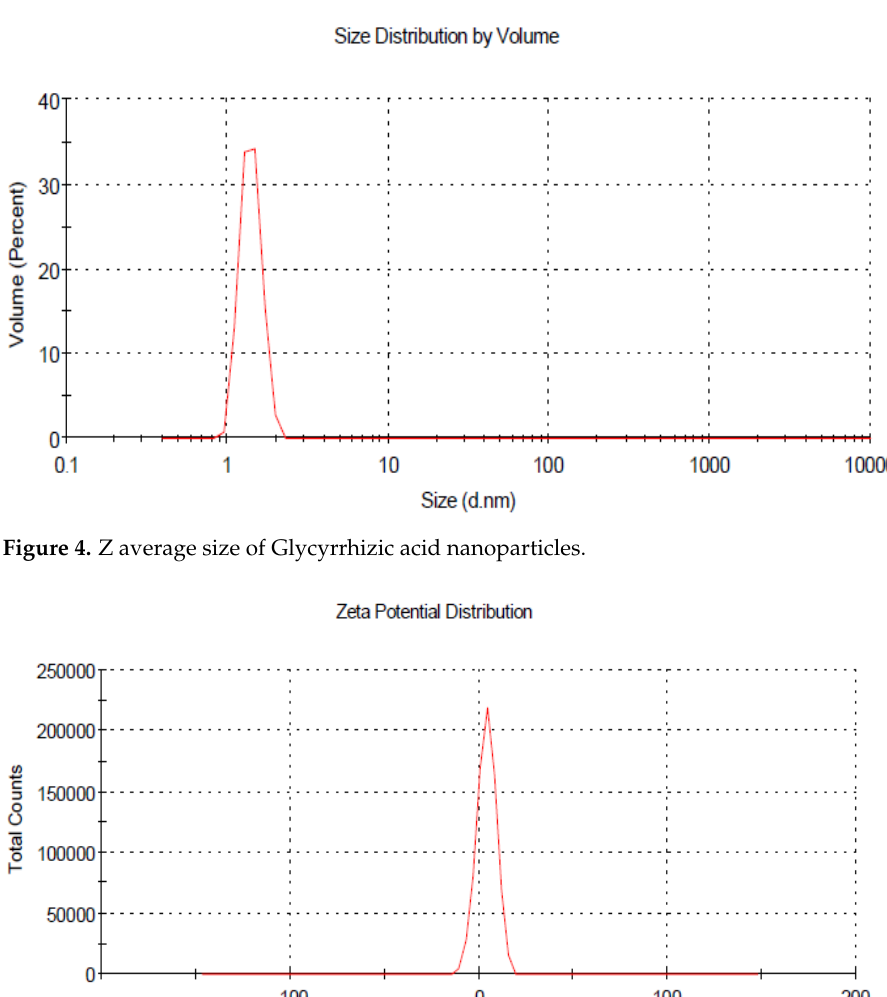
Figure 3. Zeta potential for curcumin nanoparticles.